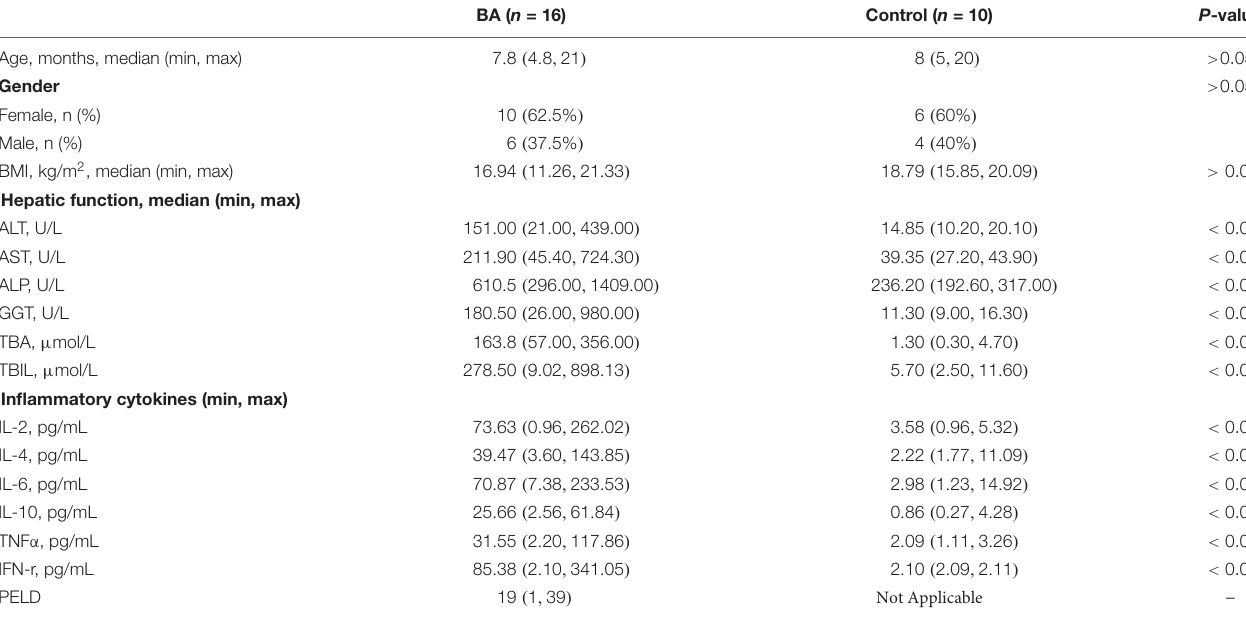
TABLE 1 | Demographic information and clinical data on patients with BA (pre-LT) and control